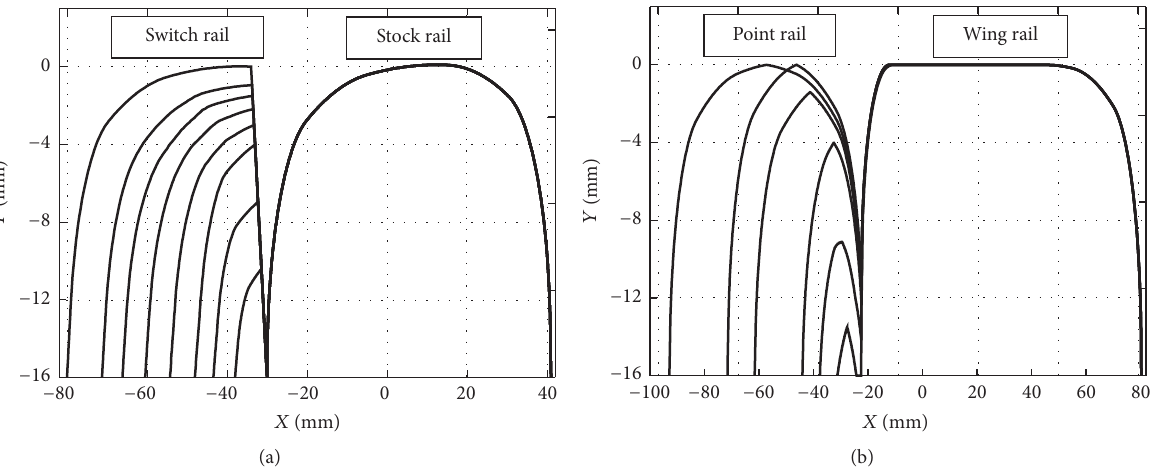
Figure 8: The cross-section sample of a switch rail and point rail ((a) switch panel; (b) crossing